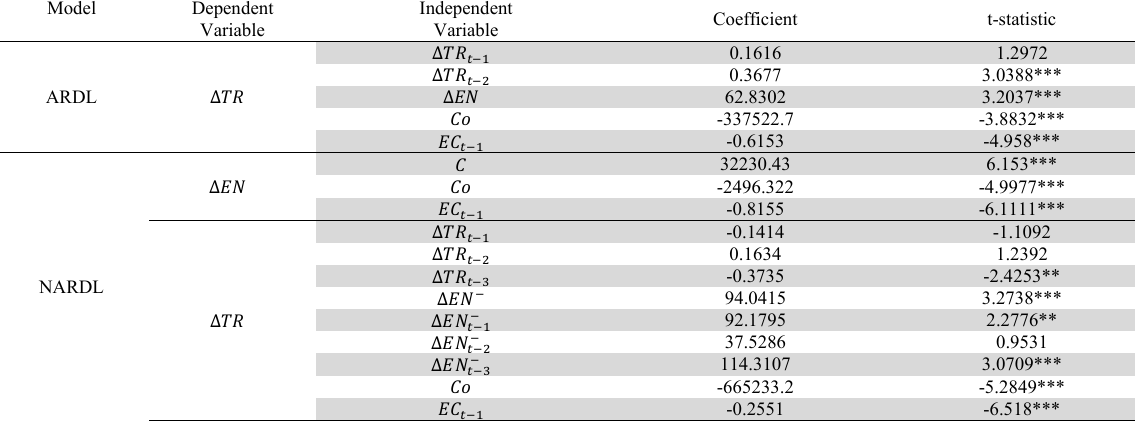
ARDL and NARDL error correction regression results